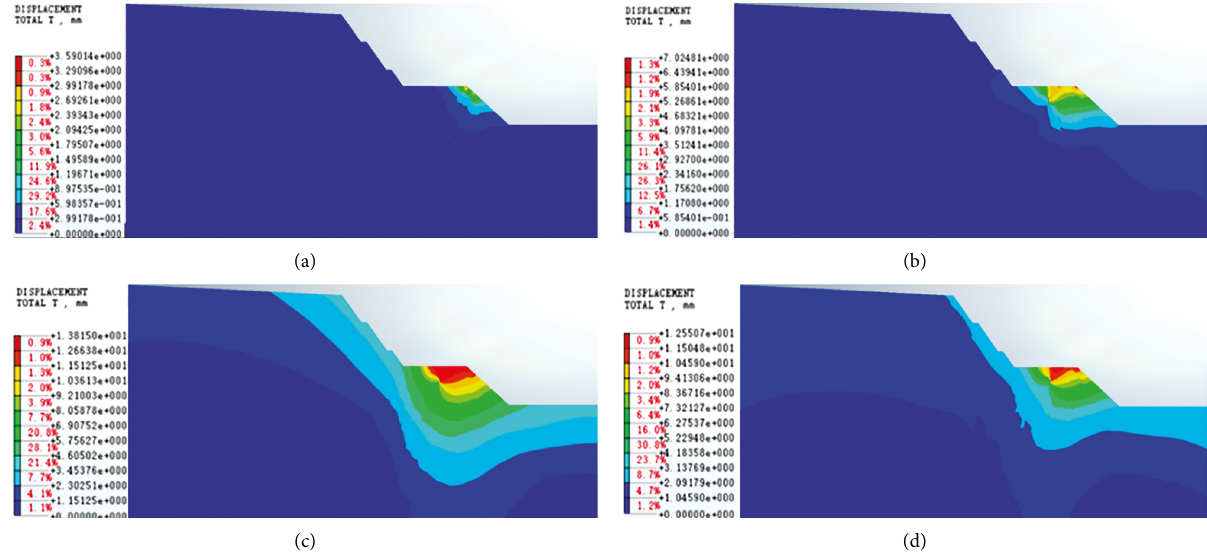
Figure 10: Displacement field nephograms of different blasting periods. (a) 75ms. (b) 150ms. (c) 225ms. (d) 300ms.